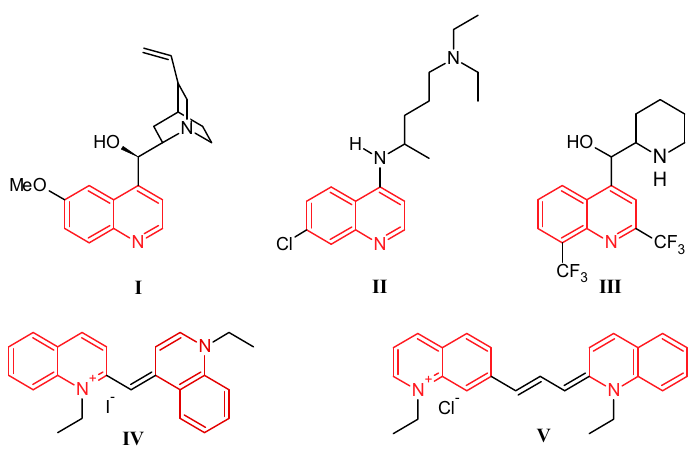
Figure 1. Structures of quinine ( I ), chloroquine ( II ), mefloquine ( III ), ethyl red iodide ( IV ), and pinacyanol ( V ).